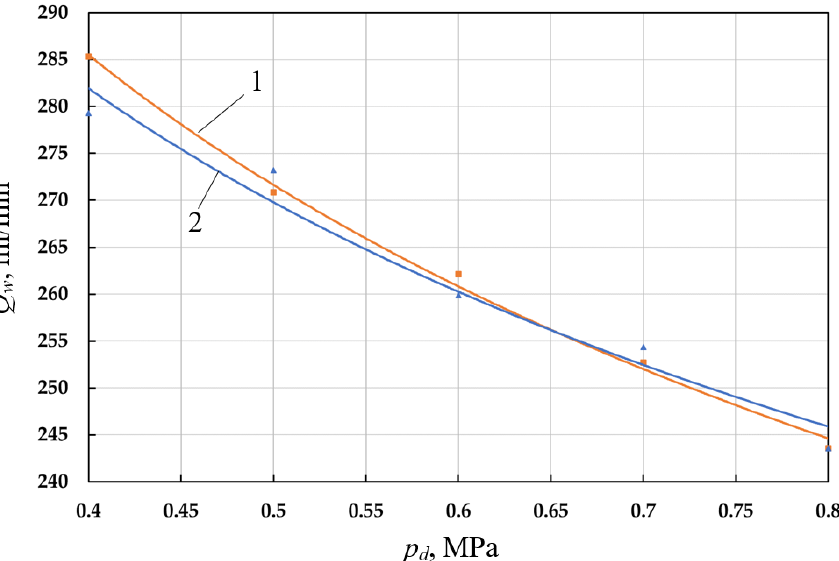
Figure 12. Dependence of the volume flow rate of the coolant of the left (1— Q w1 ) and right (2— Q w2 ) cylinders on the discharge pressure.